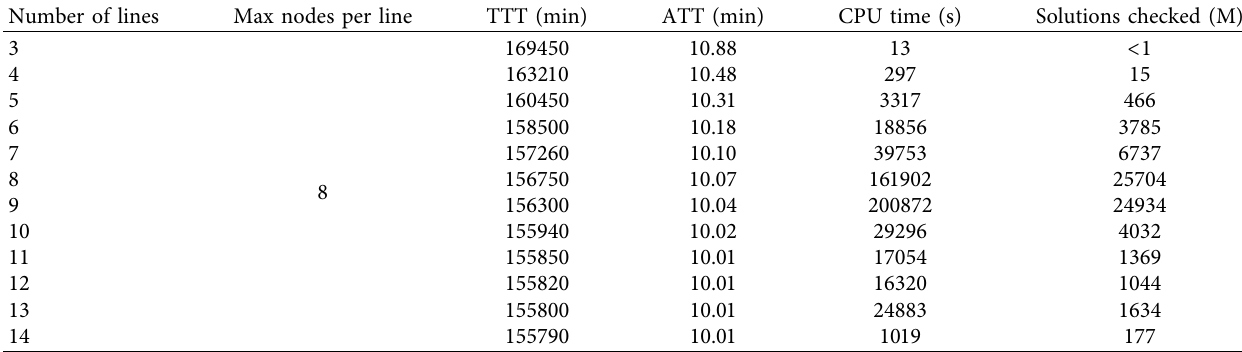
Table 1: Optimal solutions for Mandl’s Swiss network with at most 8 nodes per line. Number of lines